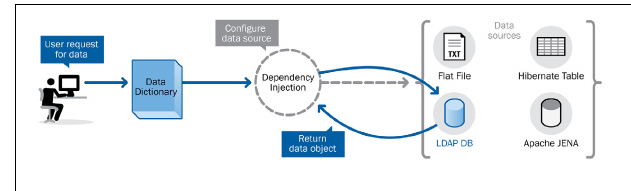
FIGURE 3 | Dependency injection allows service access while providing flexibility in implementation.